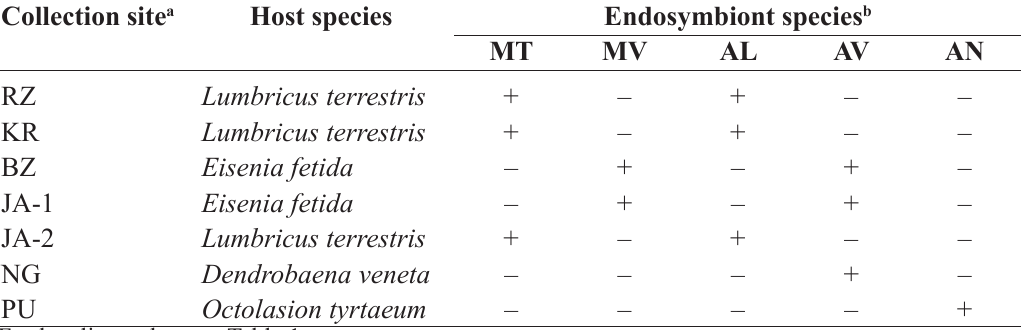
Table 2. Occurrence of astome ciliates in earthworm species examined during the course of this study. Collection site